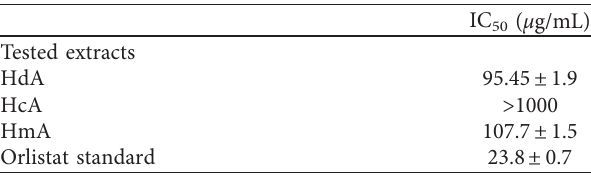
Table 3. HdA exhibited higher inhibitory activity than the